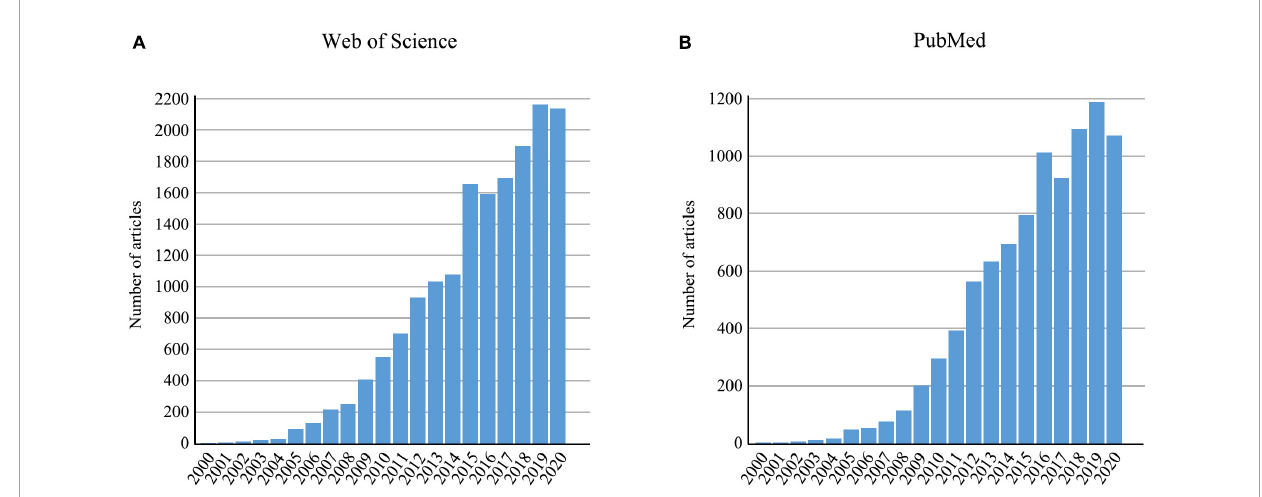
FIGURE1 The number of articles retrieved using “DNA barcod*” from 2000 to 2020 in (A) Web of Science and (B) PubMed.